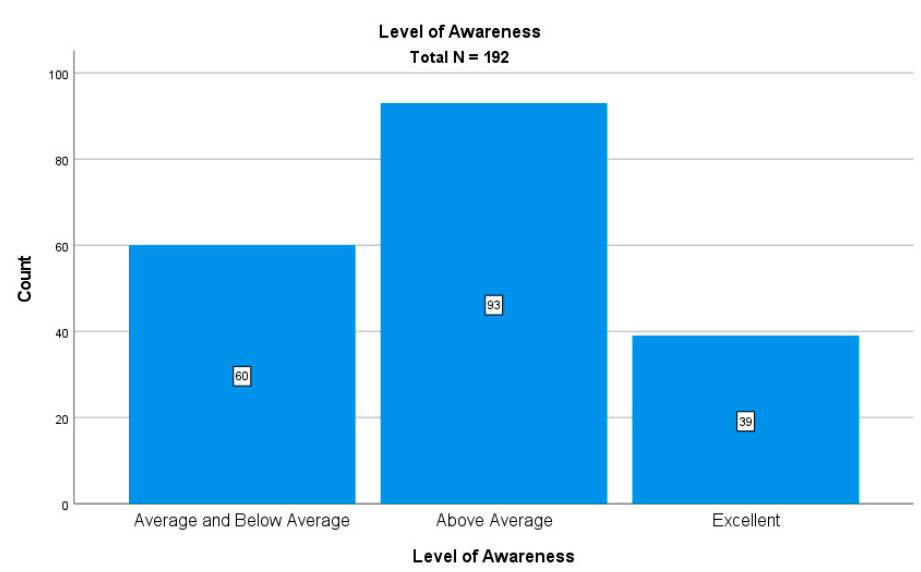
When evaluating the participants’ level of awareness of COVID-19, most respondents rated themselves to be above average (see Figure 1).